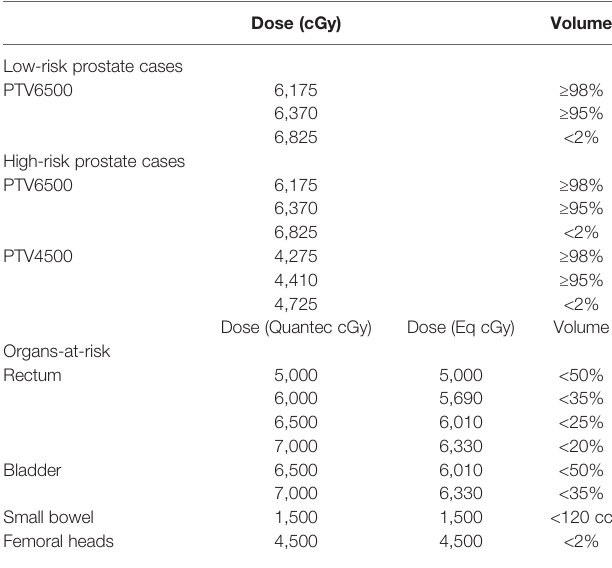
TABLE 1 | Clinical objectives for treatment planning. For the OARs, the Quantec doses were converted to their radiobiological equivalents (using BED and ab = 3 Gy) to determine the corresponding dose-volume objectives in the present hypofractionated